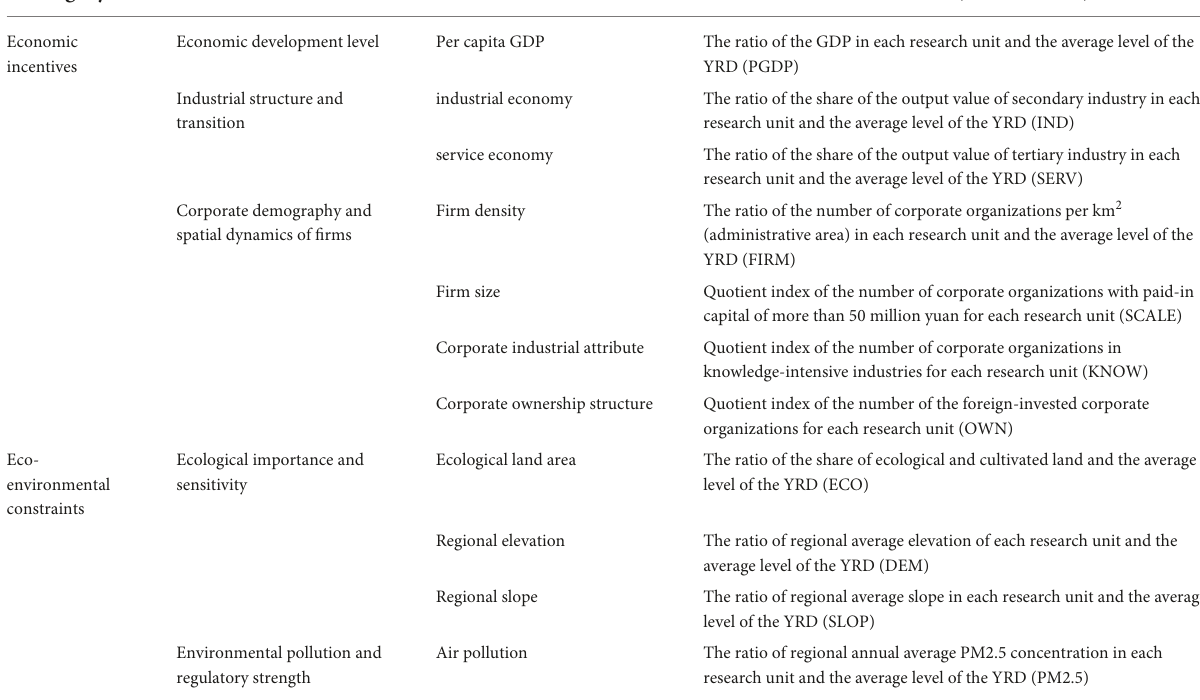
TABLE 1 The definitions of independent